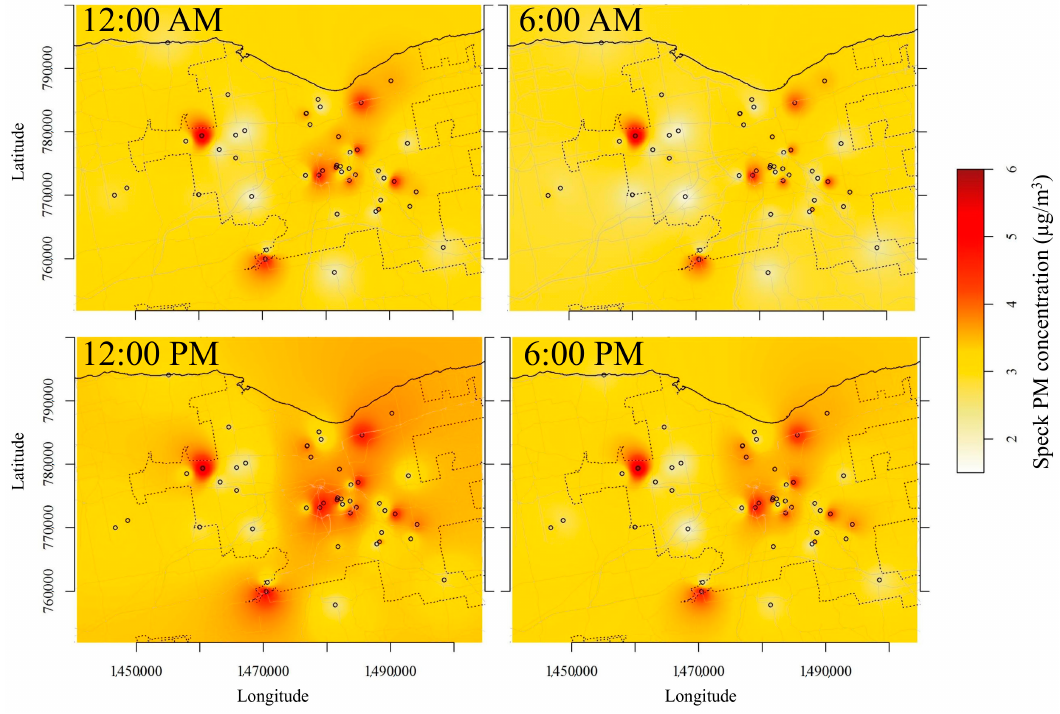
Figure 8. Hourly spatial distributions at the county at midnight, 6 a.m., noon, and 6 p.m., averaged over the two periods.